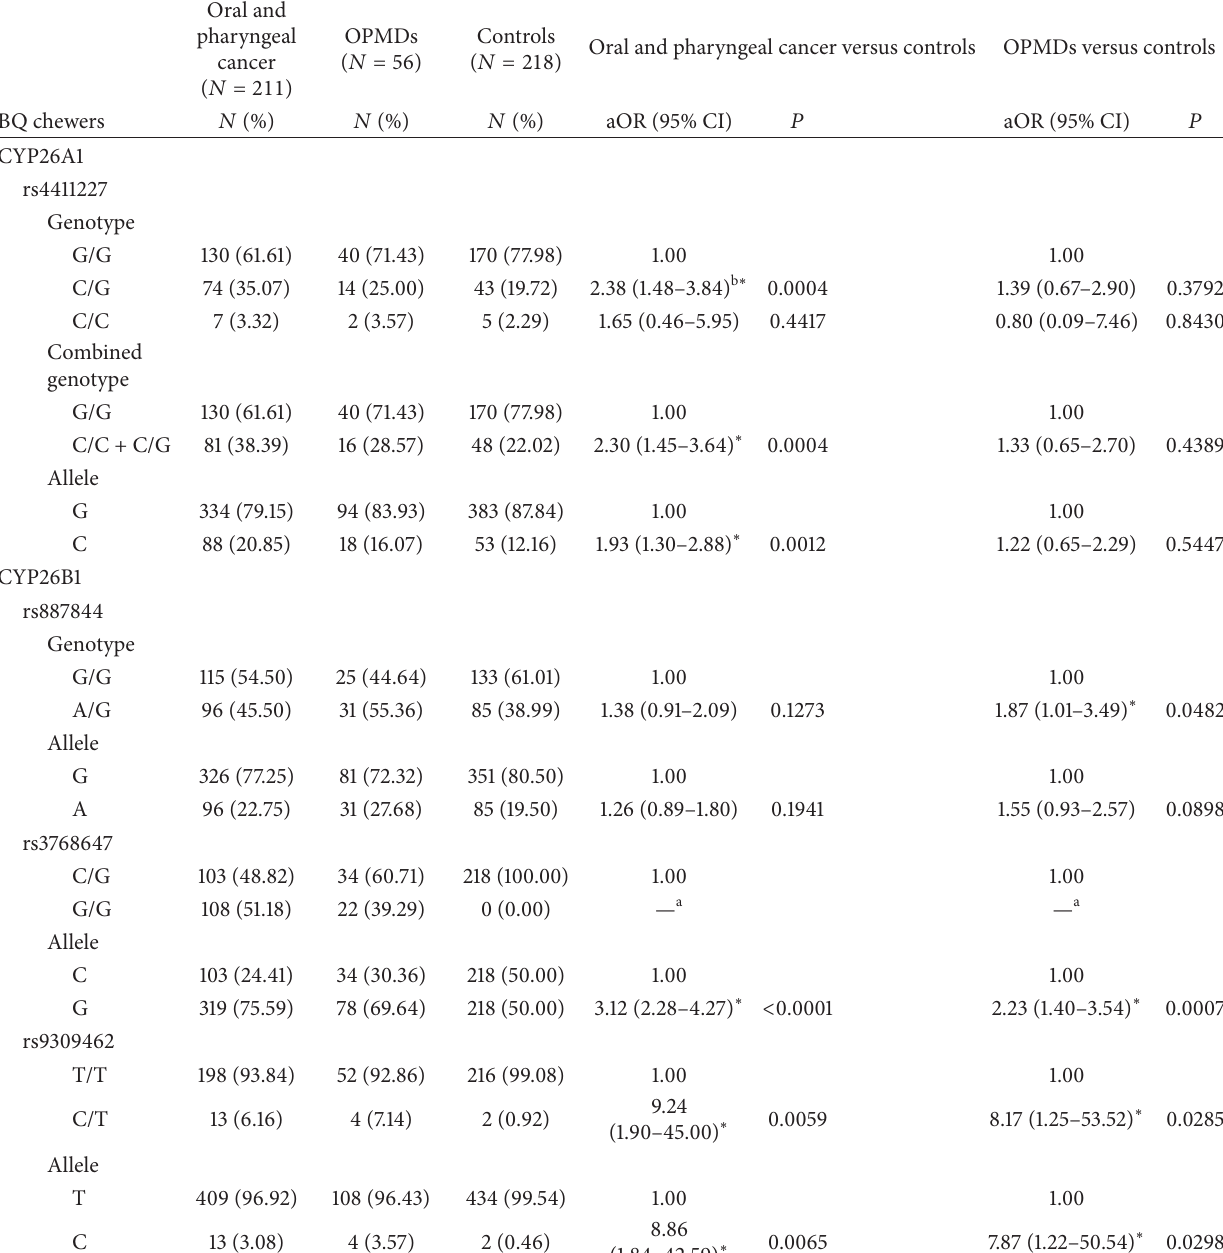
Table 2: Distribution of CYP26 families genotype and allele frequency among malignant oral disorders patients and control